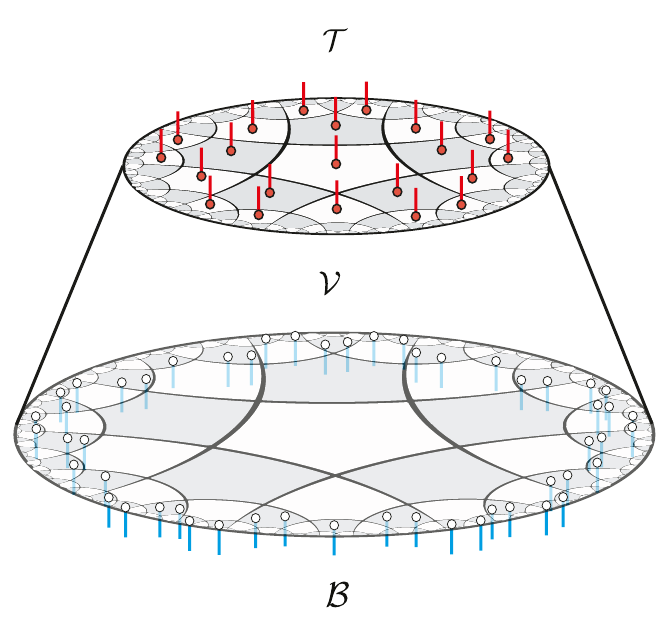
Figure 8. The isometry for the same HaPPY code as in figure 7 but without the internal structure of the tensor network. This pictorial depiction is useful in section 5 when visualizing the composition of the HaPPY isometry with other maps. The red legs correspond to the Bulk/input legs, denoted by red circles in fig 7, while the blue legs correspond to the Boundary/output legs, depicted there as white